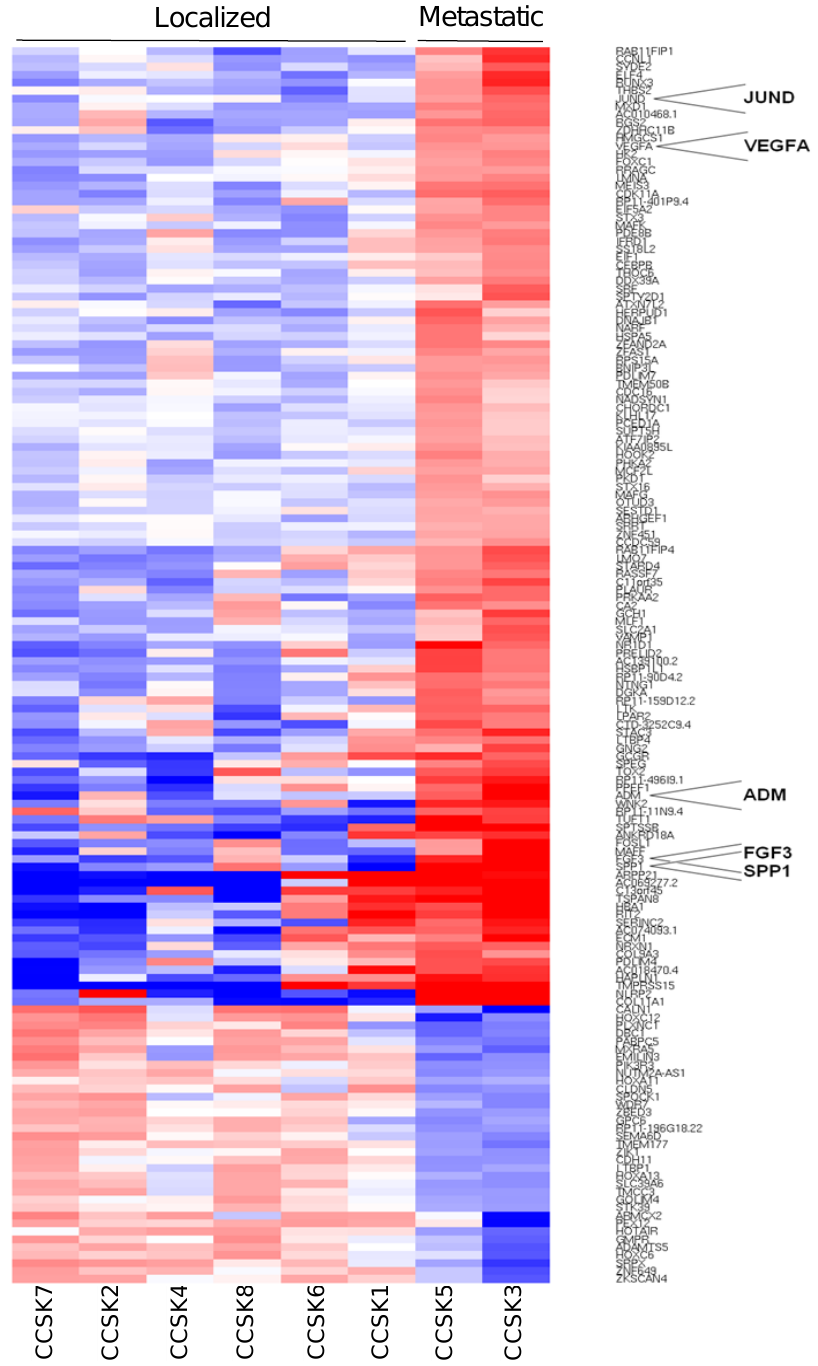
Figure 1. Hierarchical clustering of the 156 genes differentially expressed between metastatic and localized CCSK (121 up-regulated in metastatic CCSKs and 35 down-regulated; p < 0.01). The genes validated and discussed in study are highlighted.